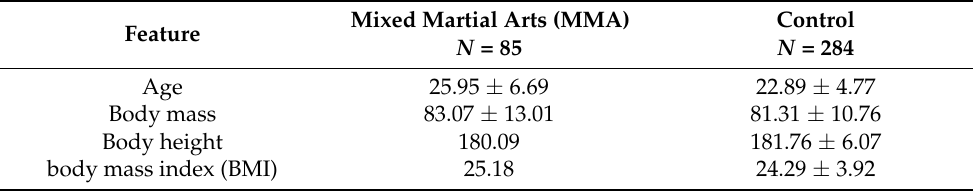
Table 1. Fundamental biological features of tested mixed martial arts (MMA) group and control